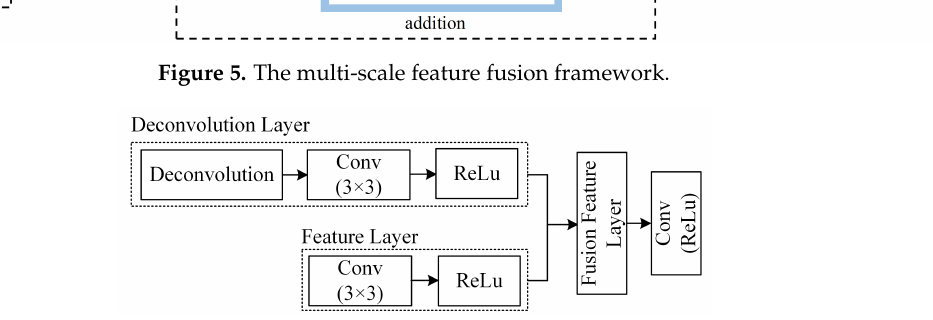
Figure 6. Deconvolution and the feature fusion